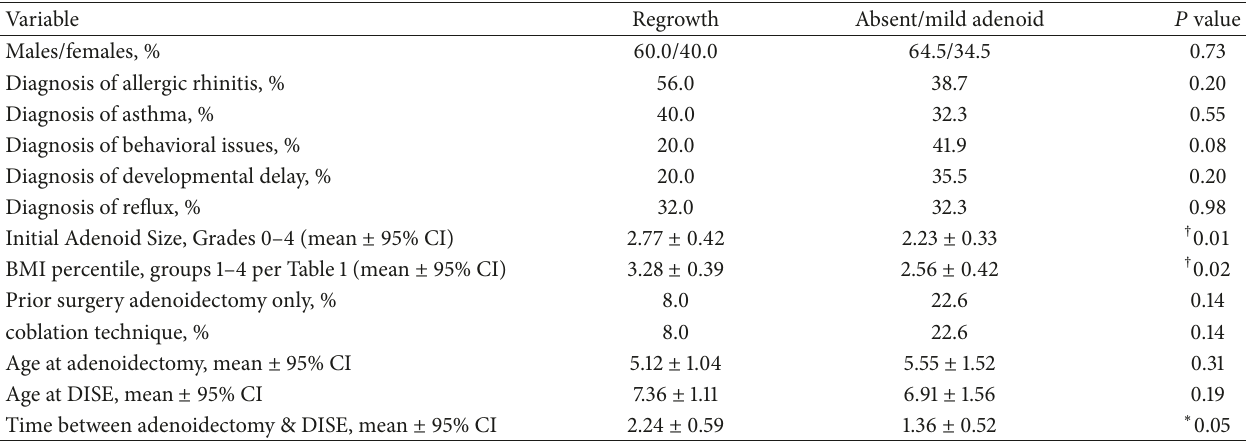
Table 3: Factors associated with adenoid regrowth as determined by